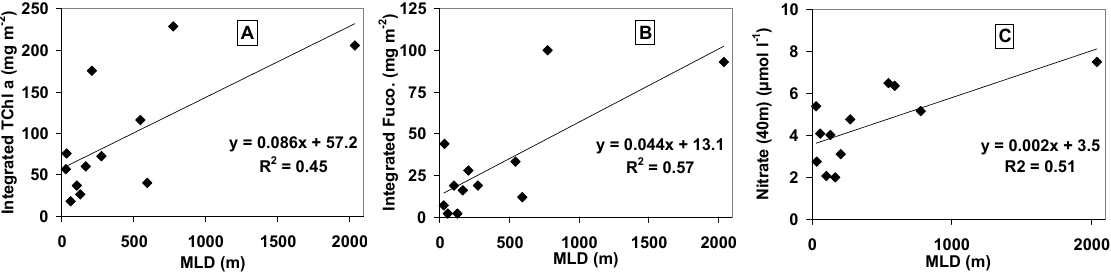
Fig. 9. (A) Correlation between maximum winter MLD and annual integrated chlorophyll a ; (B) Correlation between maximum winter MLD and annual integrated fucoxanthin. (C) Correlation between maximum winter MLD and maximum nitrate concentration at 40m depth in early